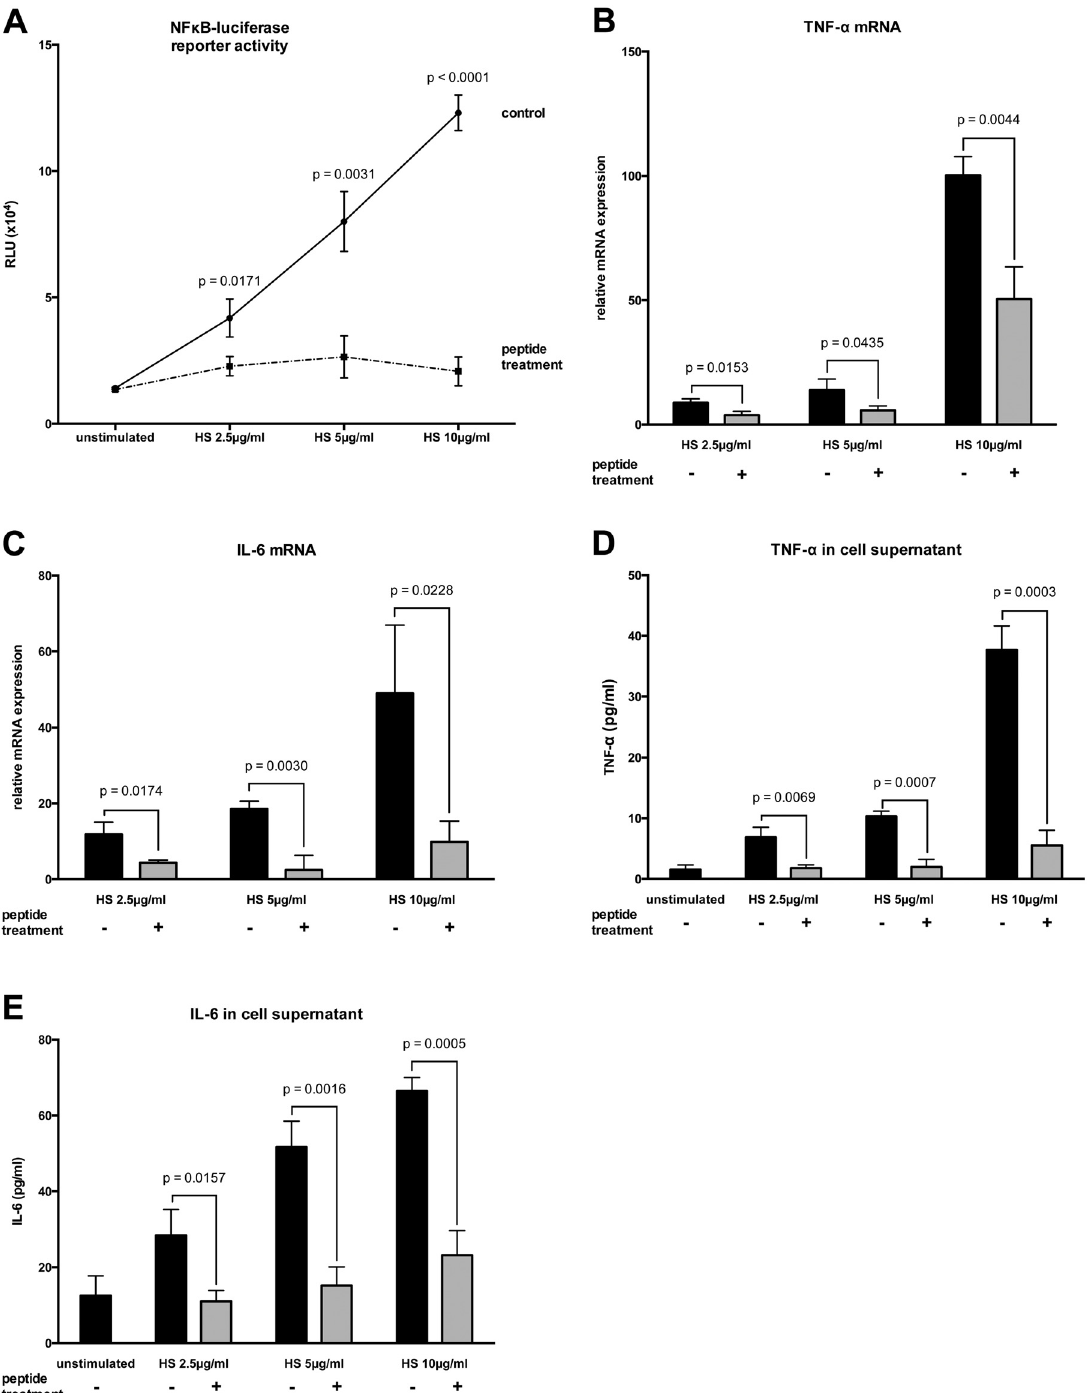
Fig 3. HS-mediated inflammatory response in HL-1 cells. (A) The cells were stimulated for 4 h with different concentrations of heparan sulfate (HS) and treated with peptide 19 – 2.5 (20 μ g/ml; dashed line) or 0.9% NaCl (control; solid line). The data are expressed as the ratio of firefly to Renilla luciferase activity in relative light units (RLU). (B and C) HL-1 cells were stimulated as described for A. Following a 4-h stimulation, the induction of mRNAs encoding the pro- inflammatory TNF- α (B) and IL-6 (C) cytokines were monitored by RT-PCR. The inductions shown are normalized to non-stimulated cells. (D and E) Secreted protein concentrations of TNF- α (D) and IL-6 (E) were determined in supernatants using ELISA. Data represent the mean ± SD of triplicate samples, representative of three independent experiments. P values represent statistically significance between untreated (control) and treated cells with peptide 19 – 2.5 (peptide treatment) using multiple t-test with Holm- Š ídák correction.